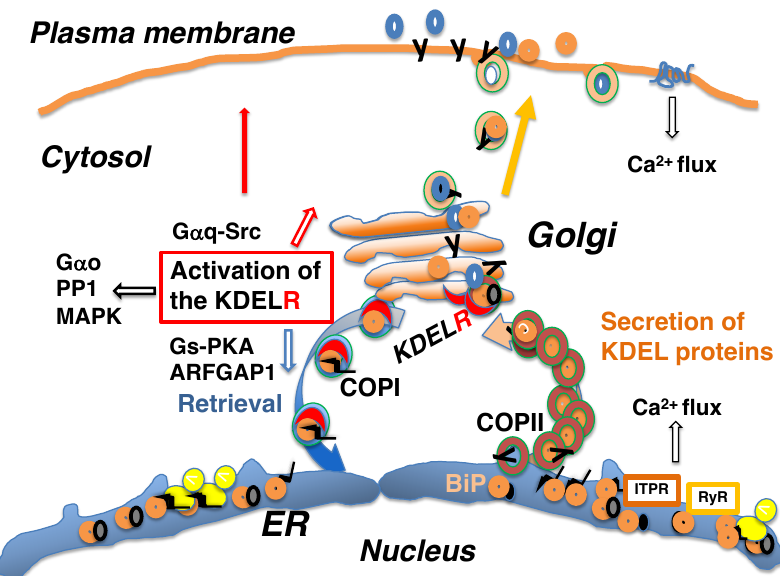
Figure 5. Activation of the KDEL receptor by secretion of endoplasmic reticulum (ER)-resident chaperones or KDEL sequence-containing proteins from the ER regulates intracellular transport, as well as several cellular signaling pathways. Activation of cell surface receptors may initiate Ca 2 + release from the ER through the inositol 1,4,5-triphosphate receptor (ITPR) or the ryanodine receptor (RyR), inducing secretion of KDEL proteins from the